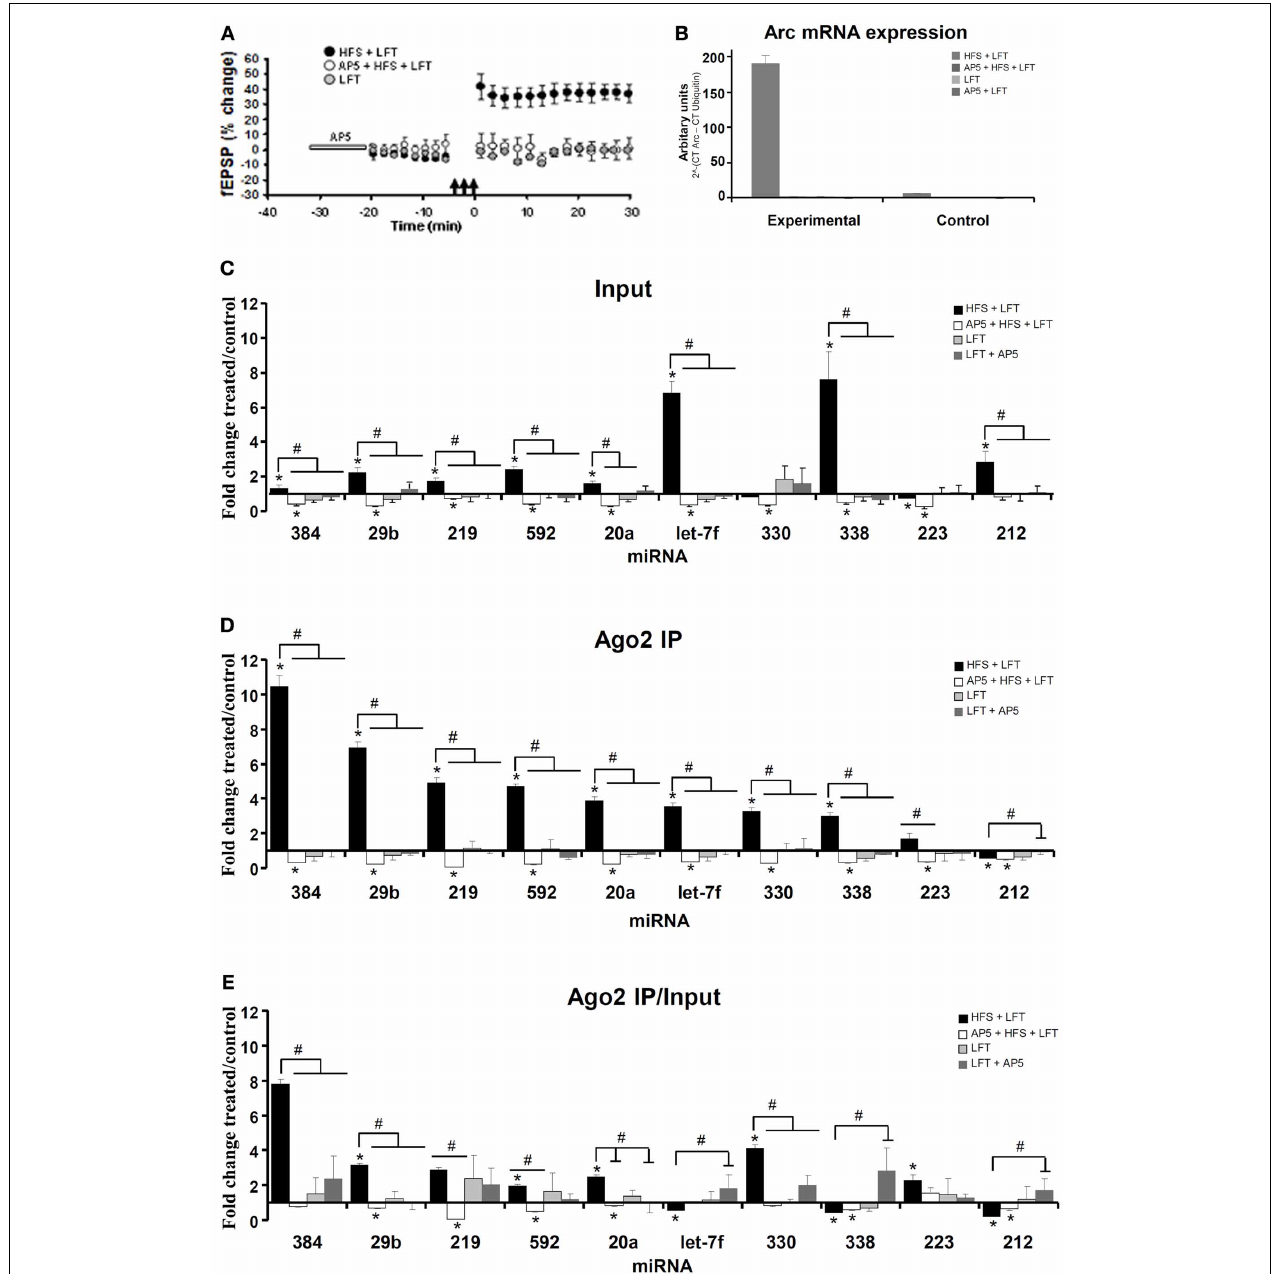
FIGURE 3 | Differential expression of Ago2-associated and total miRNAs linked to NMDA receptor-dependent LTP induction. (A) Time course plot showing changes in the medial perforant path-evoked fEPSP slope expressed as a percentage of baseline. Values are mean ( ± s.e.m.). HFS + LFT, n = 6; AP5 + HFS + LFT, n = 4; LFT, n = 3. Dentate gyrus tissue was obtained at 30min. (B) Quantitative PCR was used to validate the expression of Arc mRNA. Changes in Arc mRNA levels in the treated and contralateral control dentate gyrus lysate samples were analyzed. The PCR data was normalized to the expression of Ubiquitin-B using the (cid:3) Ct method. Values are mean ( + s.e.m.). HFS + LFT, n = 6; AP5 + HFS + LFT, n = 4; LFT, n = 3: AP5 + LFT, n = 5. (C–E) Quantitative TaqMan PCR was used for independent analysis of 10 selected miRNAs from the PCR card screen. The same set of miRNAs